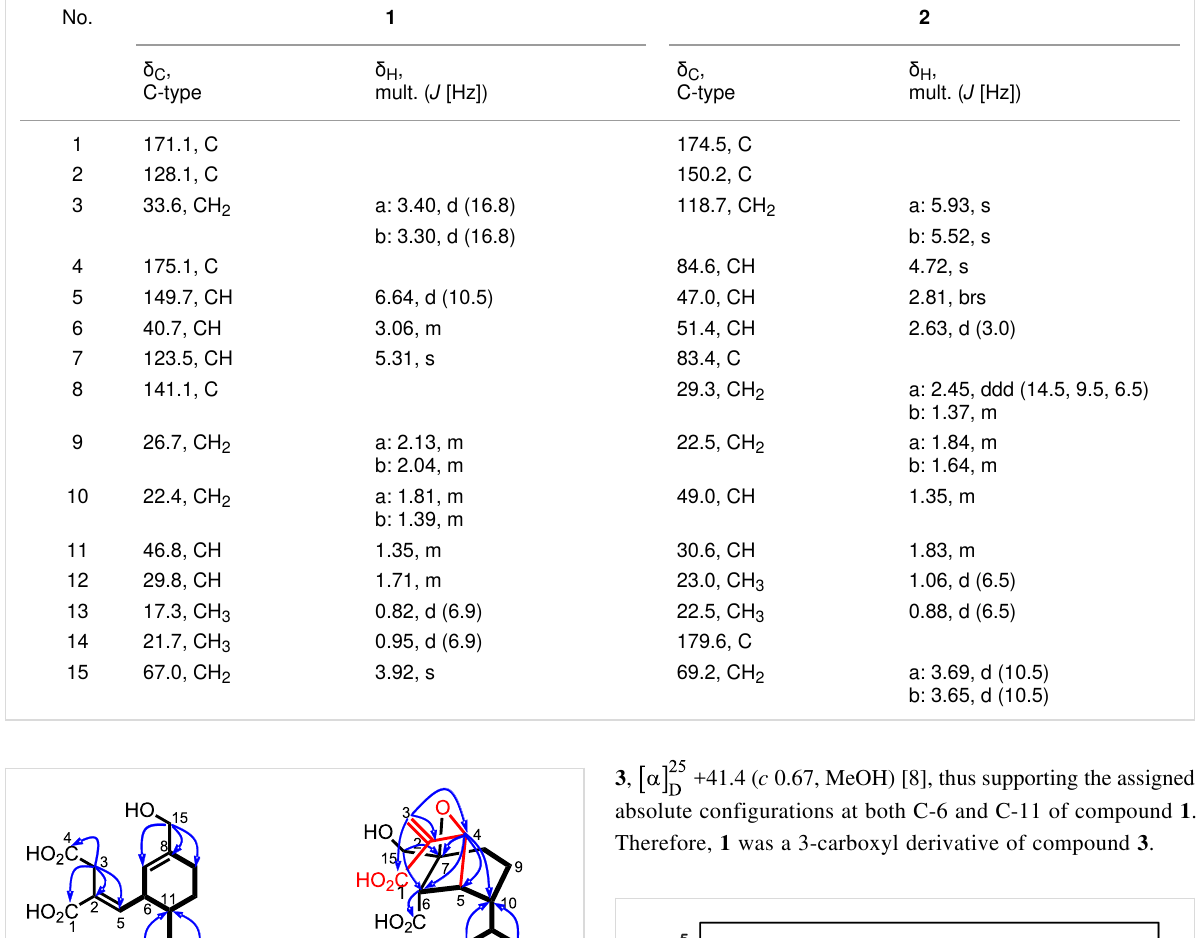
Table 1: The NMR data of compounds 1 and 2 in CD 3 OD.